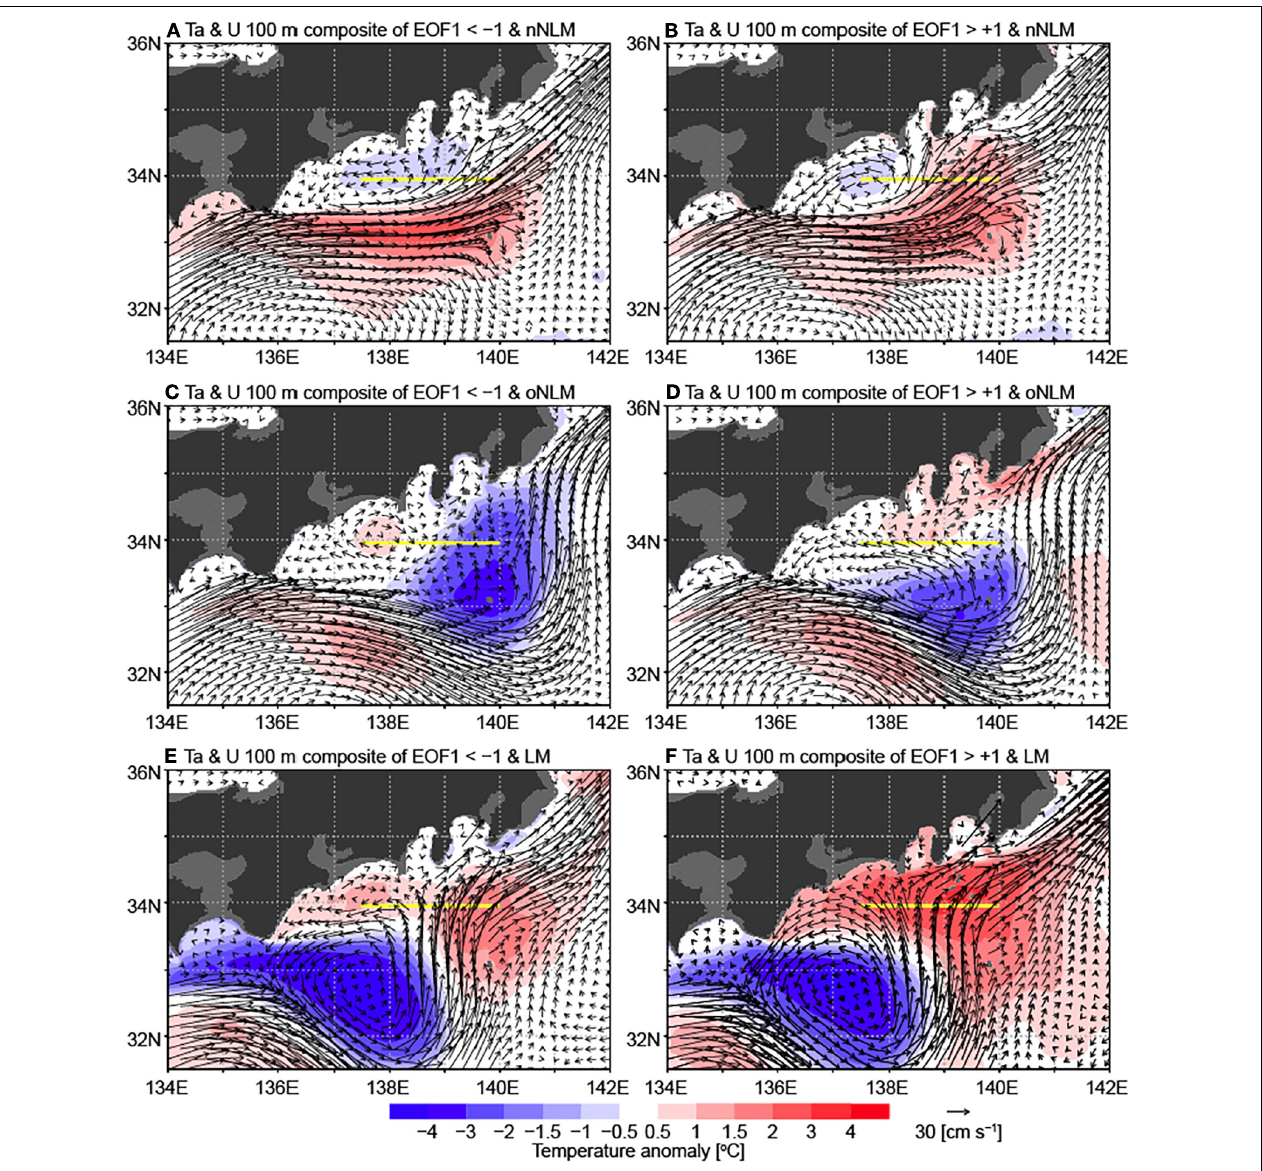
FIGURE 5 | Horizontal distributions of potential temperature anomalies (from daily climatologies; shading) and velocities (arrows) at 100 m depth. Composites of the daily values when the EOF1 time coefficient is smaller than − 1 (A,C,E) and greater than +1 (B,D,F) for the nNLM (A,B) , oNLM (C,D) , and LM (E,F) periods. Yellow lines denote the 33.95 ◦ N zonal section as examined in Figure 6